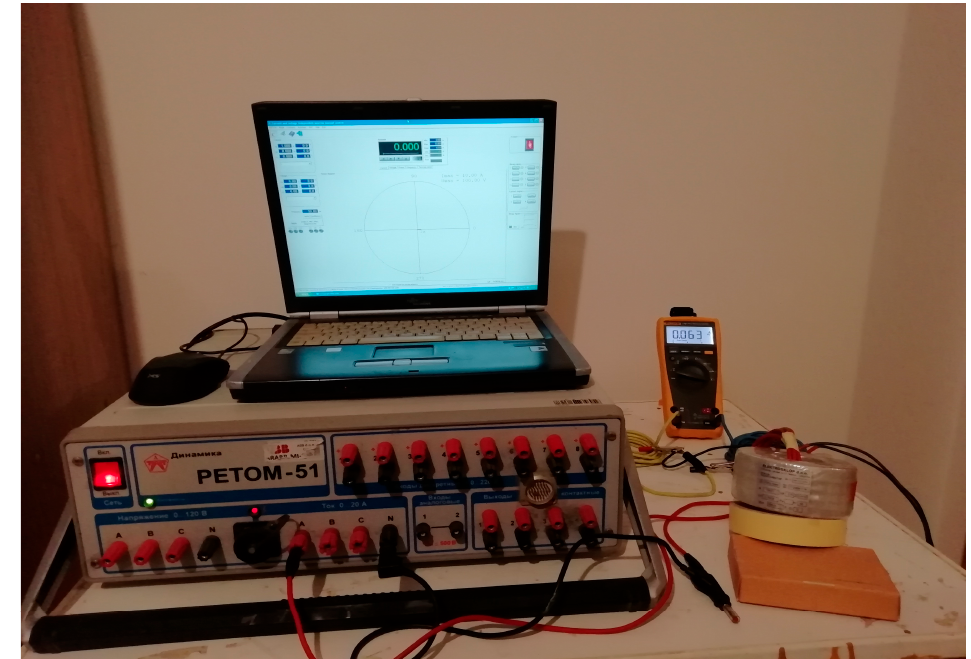
Figure 3. Setting of the experiment.